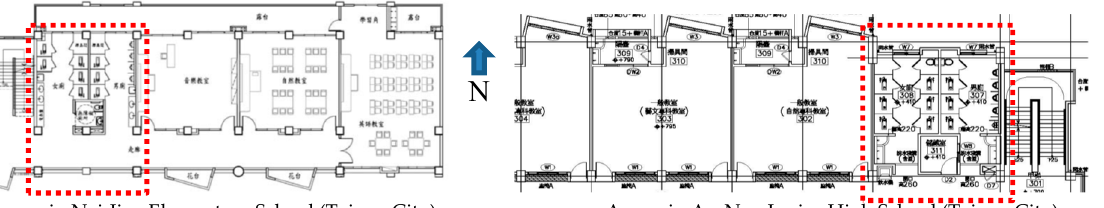
Figure 2. Awning window examples.